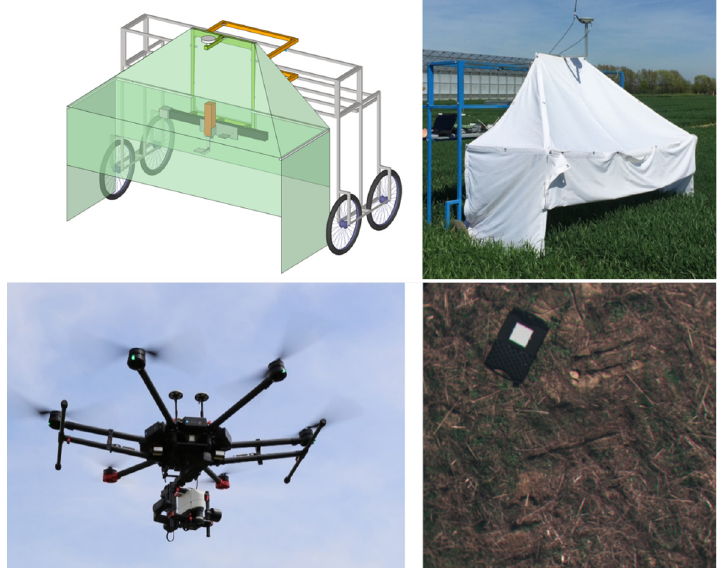
Figure 3. Construction plan of the Phytobike ( top left ) and the final appearance in the field including the cotton diffuser ( top right ). The UAV system used, consisting of a DJI Matrice 600 and a Rikola hyperspectral camera ( bottom left ). Normalization was performed using a 50% grey reference panel ( bottom right ).